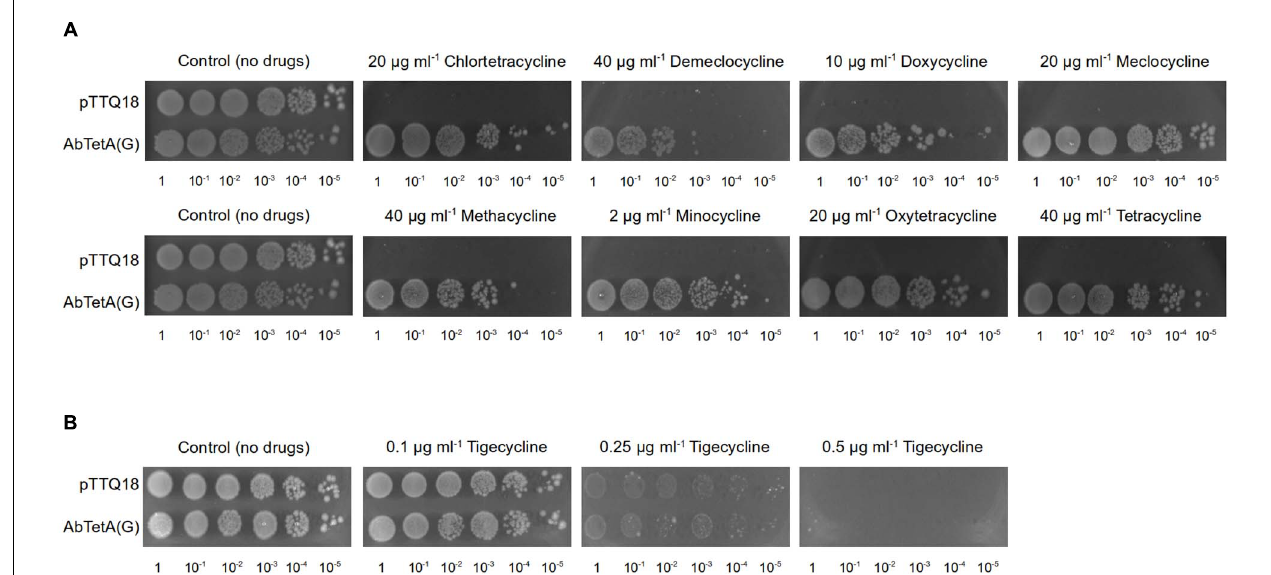
FIGURE 1 | TetA(G) from A. baumannii confers resistance to E. coli BW25113 (cid:49) emrE (cid:49) mdfA toward diverse tetracyclines. Drug susceptibility assays were conducted by spotting diluted cell cultures (OD 600 = 10 0 –10 − 5 , as indicated below the respective images) on LB agar plate supplemented with 0.2 mM IPTG and 100 µ g ml − 1 ampicillin containing (A) tetracyclines (20 µ g ml − 1 chlortetracycline, 40 µ g ml − 1 demeclocycline, 10 µ g ml − 1 doxycycline, 20 µ g ml − 1 meclocycline, 40 µ g ml − 1 methacycline, 2 µ g ml − 1 minocycline, 20 µ g ml − 1 oxytetracycline, or 40 µ g ml − 1 tetracycline). Both of the control plates are identical and both represent the same biological repeat in the same experiment (a representative). (B) tigecycline (0.1–0.5 µ g ml − 1 ). As a negative control, cells harboring pTTQ18 (empty vector) were spotted on the same agar plate. Experiments were conducted three times (biological repeats) and the results shown are representative.